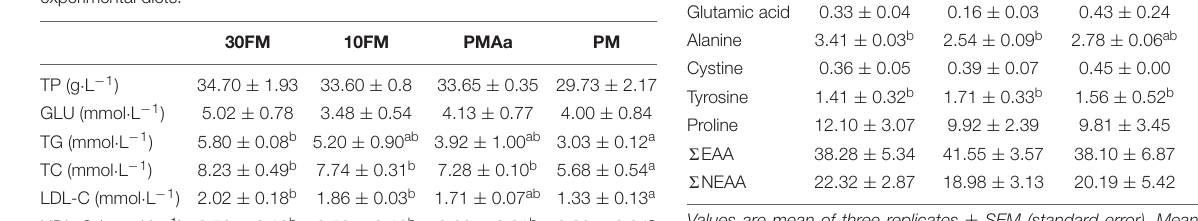
TABLE 8 | Plasma biochemical composition of gibel carp fed different experimental diets.